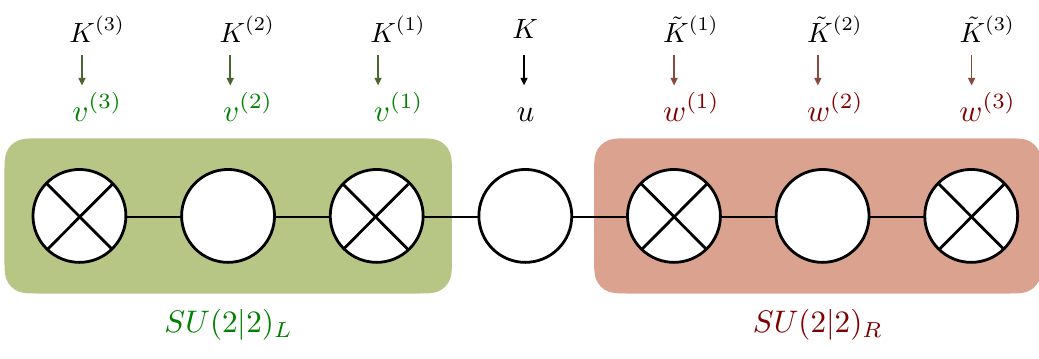
Figure 2. PSU(2 ; 2